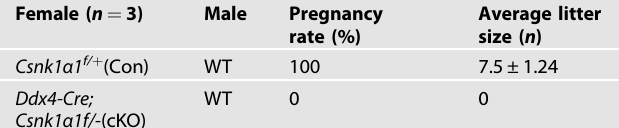
Data were shown as mean±